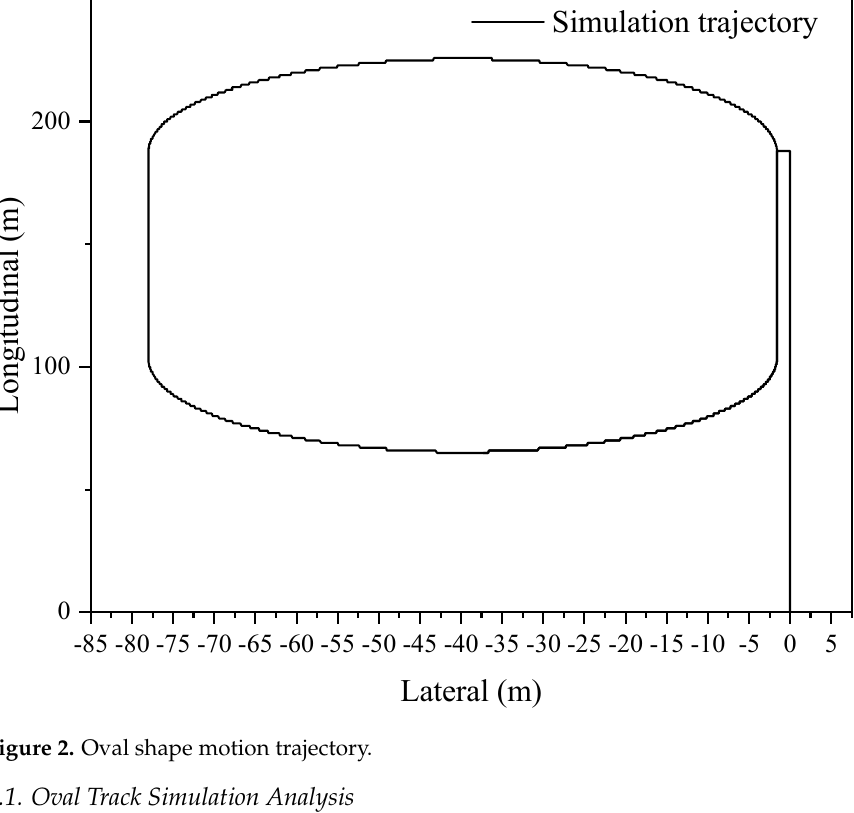
Figure 2. Oval shape motion trajectory.